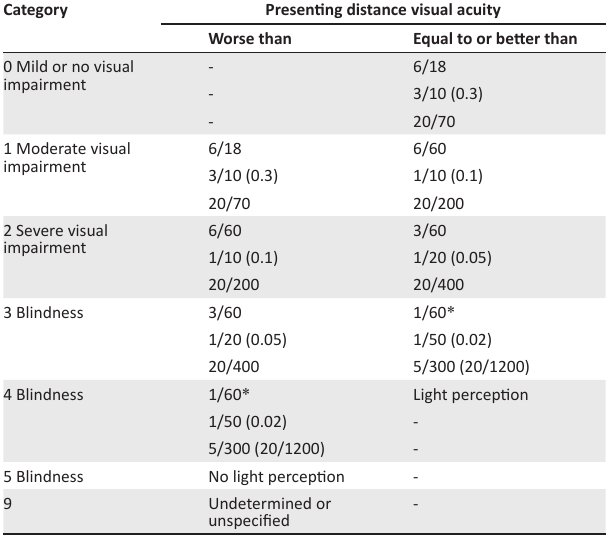
TABLE 1: The International Classification of Diseases, 10th revision classification of visual impairment.